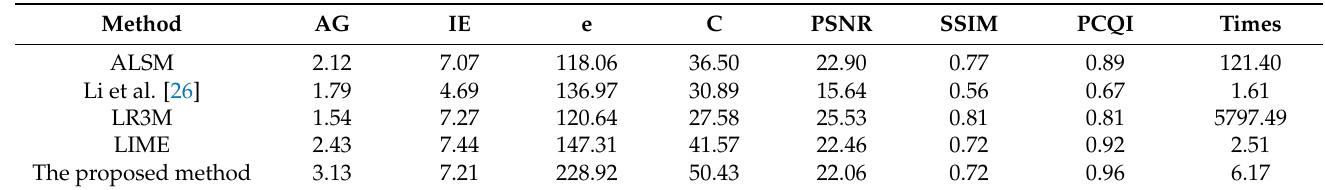
Table 3. Average values of each index of 46 images in multi-exposure dataset enhanced by differ- ent methods.